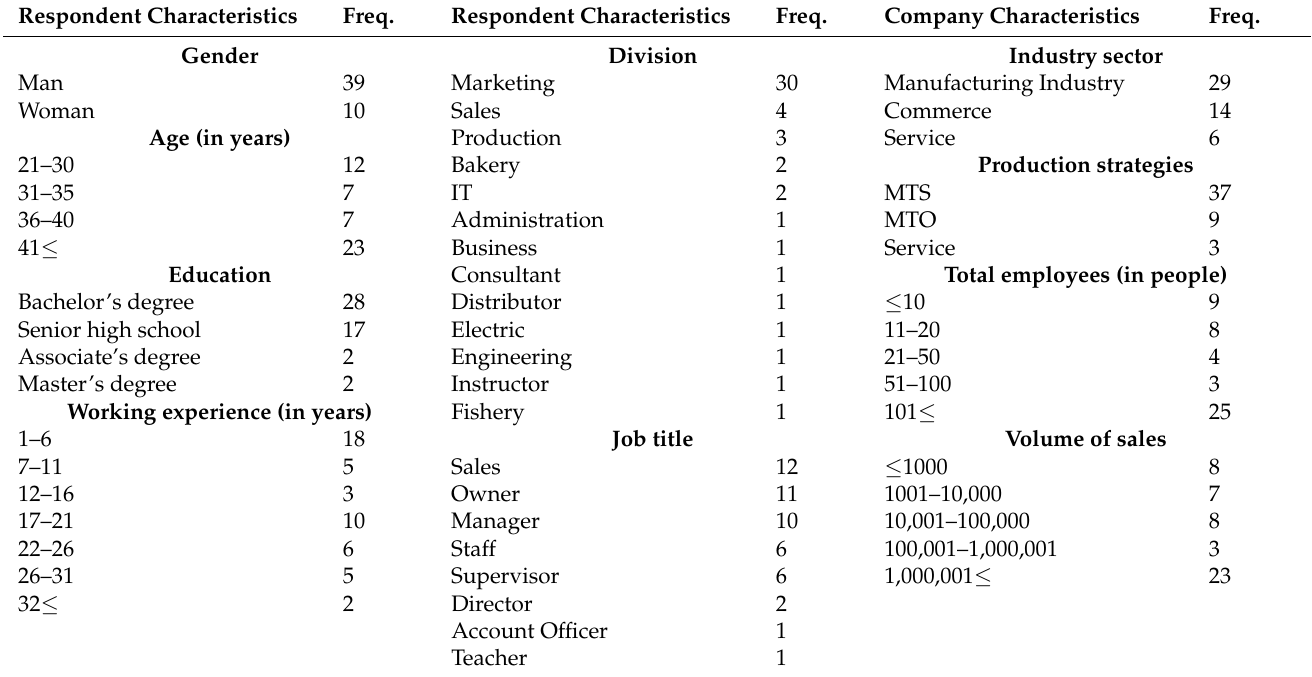
Table 2. Expert insights: The defining characteristics of the correspondents. In our study, we interviewed 49 correspondents from 26 different